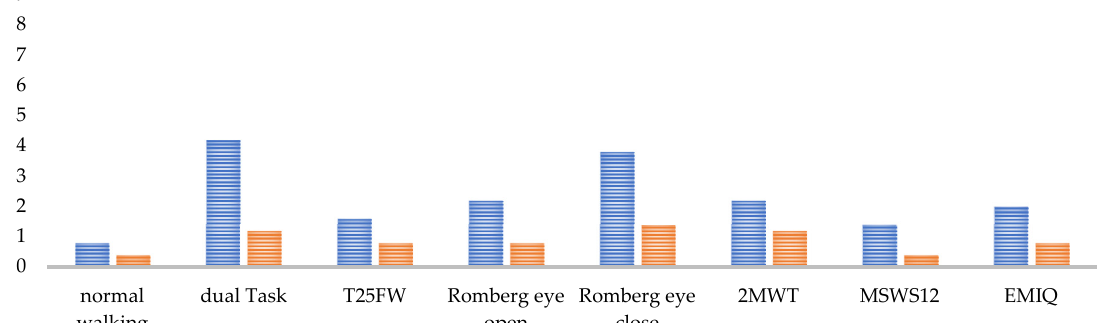
Figure 5. Test difficulty rating for each test from 0 (easy) to 10 (very difficult) for the patient and the staff from staff’s perspective. Normal walking means walking over a mat with a self-selected comfortable walking speed. T25FW = the timed 25-foot walking; 2MWT = 2-min walk test; MSWS-12 = Multiple Sclerosis Walking Scale; EMIQ = Early Mobility Impairment Questionnaire.